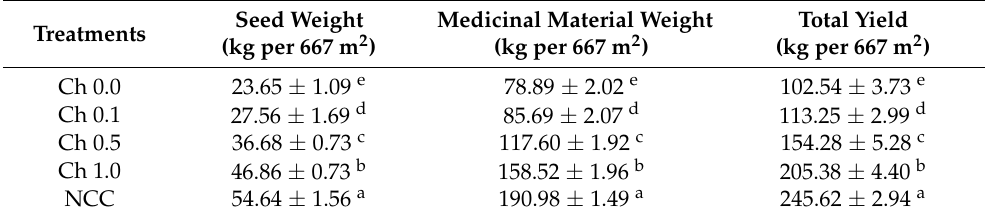
Table 2. The influence of chitosan spraying on the seed weight, medicinal material weight, and total yield of P. ternata .